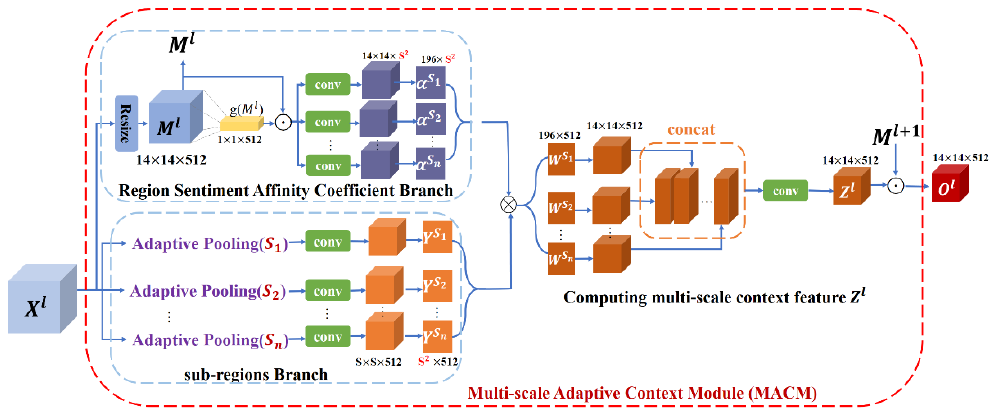
Figure 3. The process of MACM module. For the input feature graph 𝑋 𝑙 , there are two branches. One is sub-regions branch. Another one is region sentiment affinity coefficient branch. Finally, the multi-scale context features are fused with the 𝑀 𝑙+1 of the upper layer. In this figure, concat is a channel-wise concat.